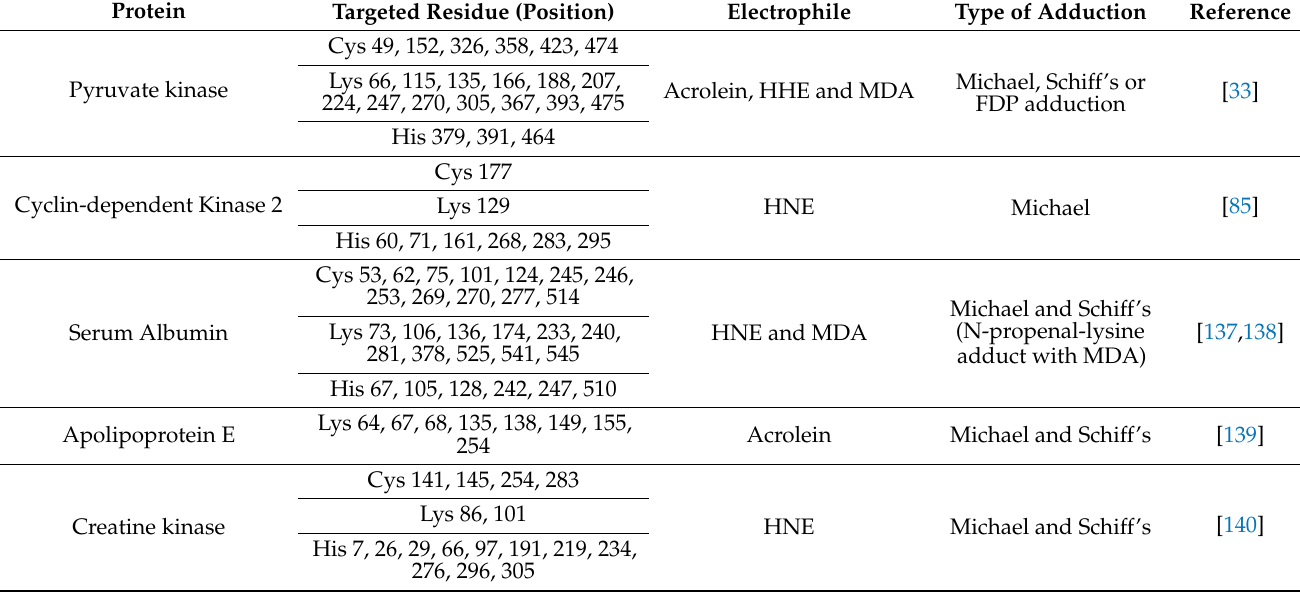
Table 3. Multiple modification mapping studies in